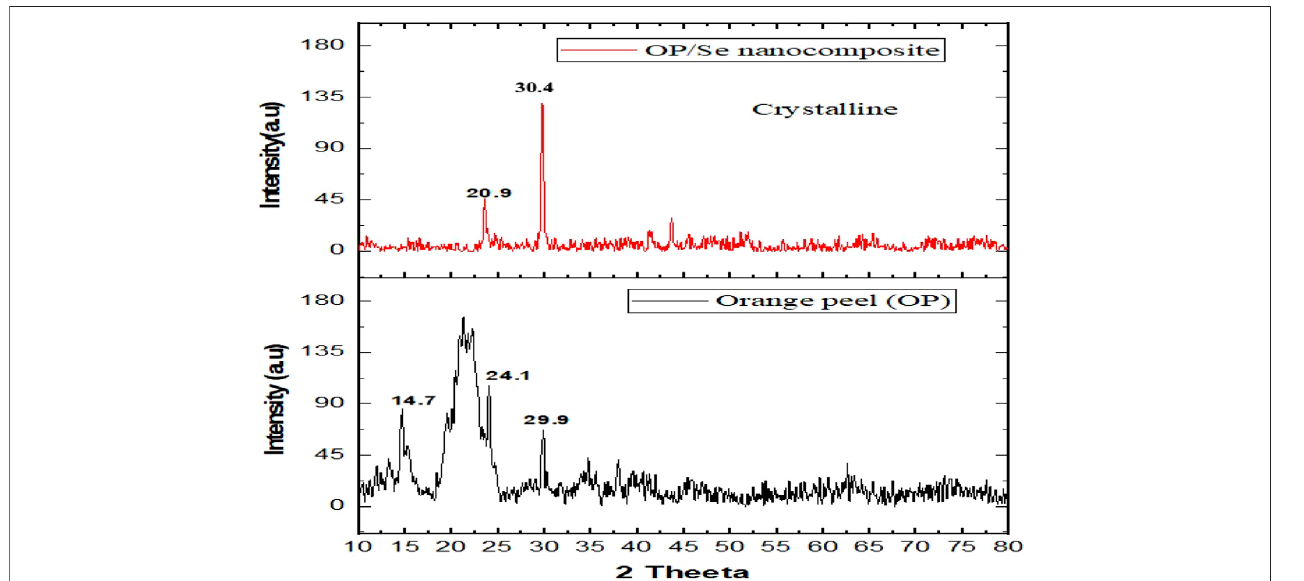
FIGURE 3 | XRD spectra of orange peel and orange peel/selenium nanocomposite.